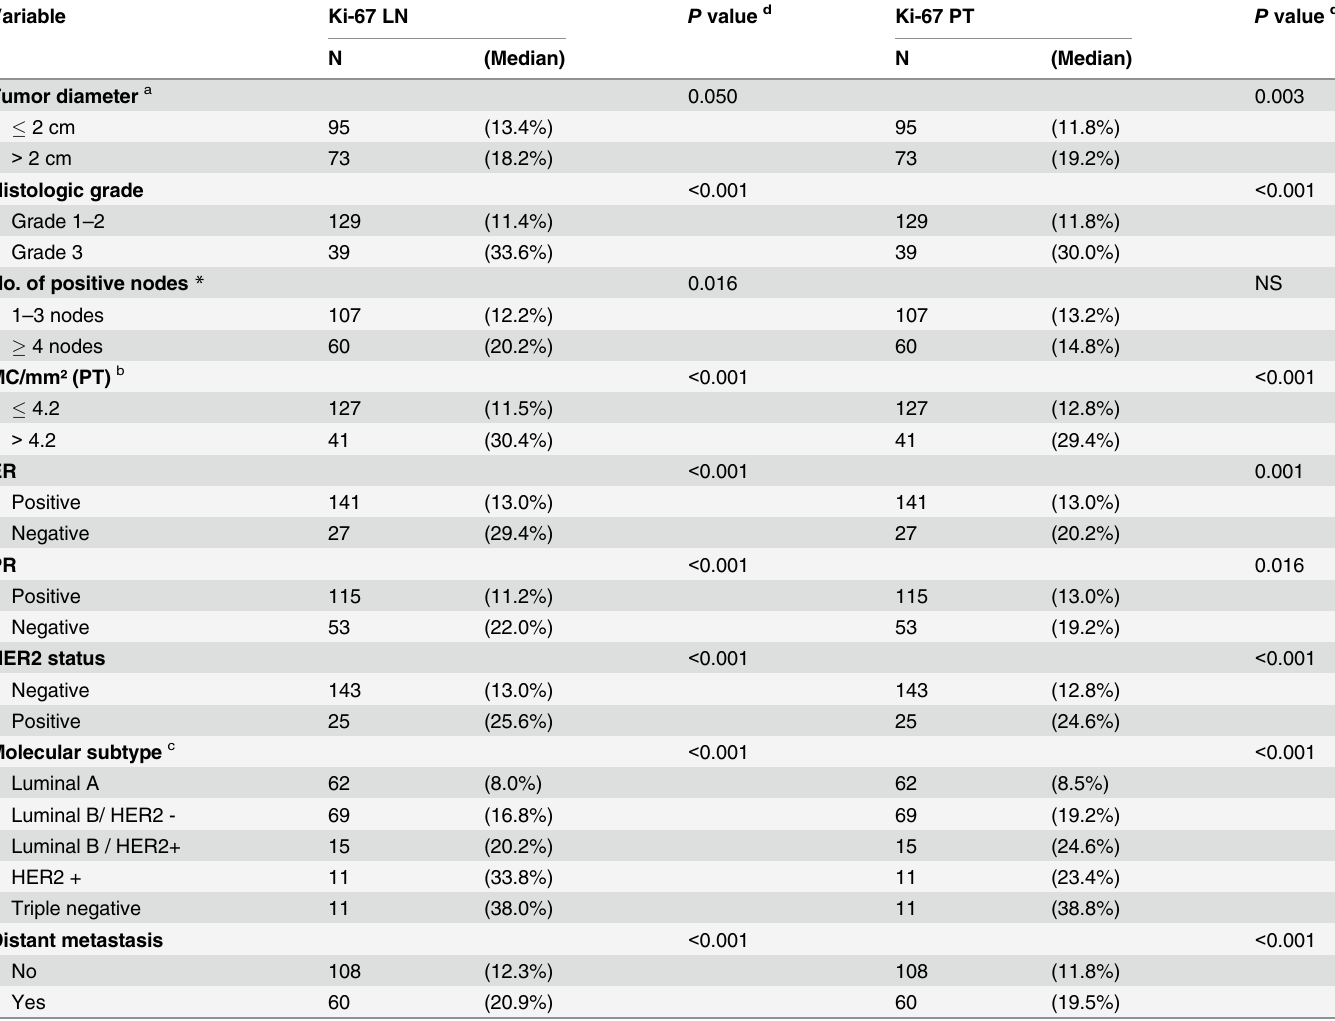
Table 1. Ki-67 expression and histopathologic features of the primary tumors.( n =